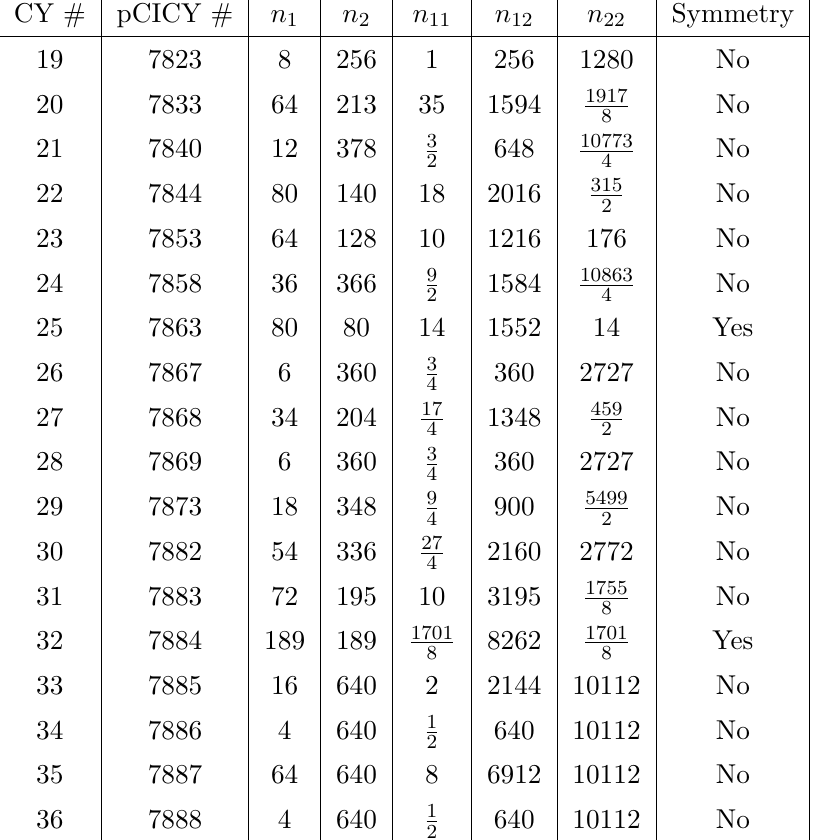
Table 8. Coefficients of the prepotential F inst in eq. (2.6) for pCICYs with h 1 , 1 = 2